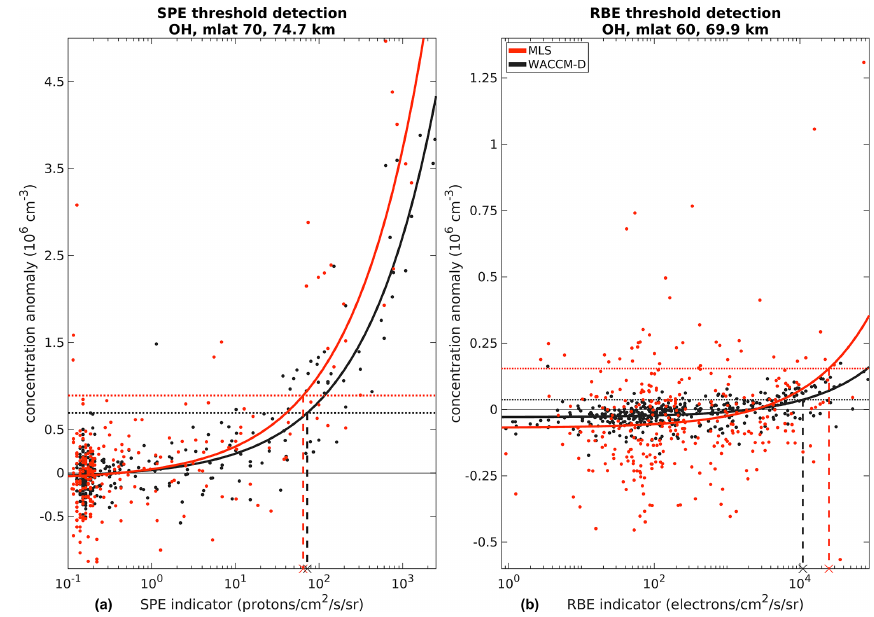
Figure 4. Precipitation threshold determination using nighttime OH. (a) SPE indicator at magnetic latitude 70 ◦ N and 0.0215hPa (74.7km) and (b) RBE indicator at magnetic latitude 60 ◦ N and 0.0464hPa (69.9km). MLS data in red and WACCM-D in black. Daily indicator and OH concentration value pairs are shown as dots, and the linear fit is shown as a solid line. Used limits (median and SD; dotted horizontal lines) and detected threshold values (dashed vertical lines) are also shown. Note that the linear fitting was done using the square roots of the flux indicator